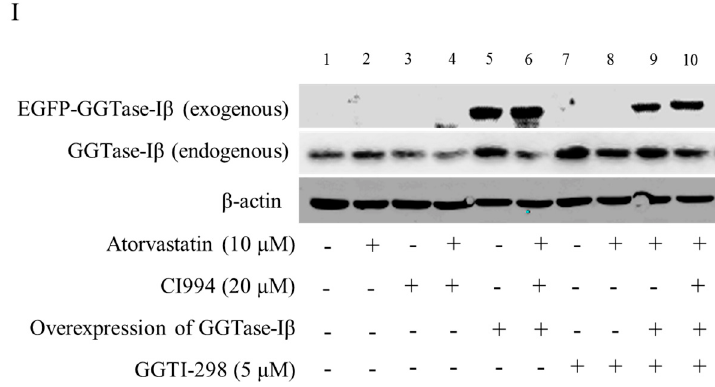
Figure 5. GGTase-I β mediated the synergistic anti-cancer effects of HDAC1 inhibitor and statin. SACC-83 and CAL27 cells were treated with either different doses of SAHA ( A ) or various kinds of HDAC inhibitor/siRNA ( B ); after 30 h treatment the total protein was extracted and subjected to Western blot. SACC-83 cells were exposed to different doses of statins (mevastatin/atorvastatin); after 30 h treatment, total mRNA and protein were extracted and subjected to either real-time PCR ( C ) or Western blot ( D ) for analysis; ( E ) GGTase-I β protein expression after treatment with either statin (mevastatin/atorvastatin), or CI994, or both for 30 h in SACC-83 cells; ( F ) SACC-83 cells were transfected with either EGFP-fused GGTase-I β , or an empty vector, after transfection cells were exposed to atorvastatin at a concentration of 40 µ M for 48 h. Cell viability was assessed by CCK8; ( G ) Total protein was also extracted and subjected to analysis by Western blot. * P < 0.05 vs. the control group; # P < 0.05 vs. atorvastatin or GGTase-I β group, n = 4. SACC-83 cells were transfected with either an empty vector (pEGFP-C1) or EGFP-fused GGTase-I β , and then exposed to different kinds of treatment. Cell viability was assessed by CCK8 assay after 48 h treatment ( H ); Total protein was extracted and subjected to Western blot ( I ). * P < 0.05 vs. the control group; # P < 0.05 vs. atorvastatin group; $ P < 0.05 vs. combination of atorvastatin and CI994 group, n = 4.